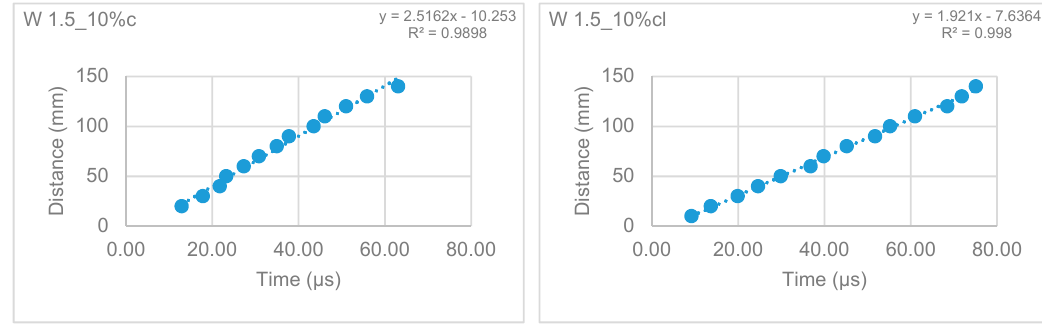
Figure 8. Ultra-sound pulse velocity of the W 1.5_10% mortar.